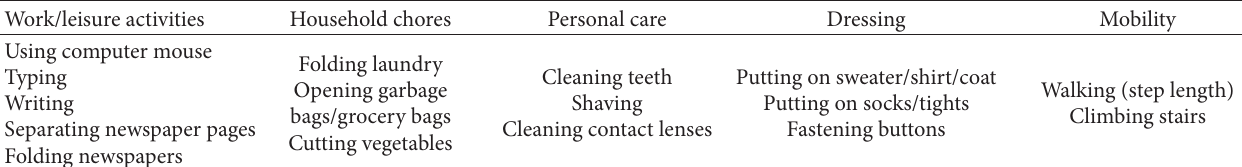
Walking (step length) Climbing